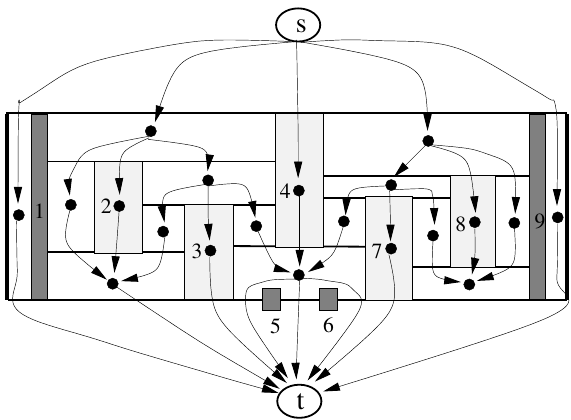
Figure 20. The flow graph of the separation visibility graph shown in Figure